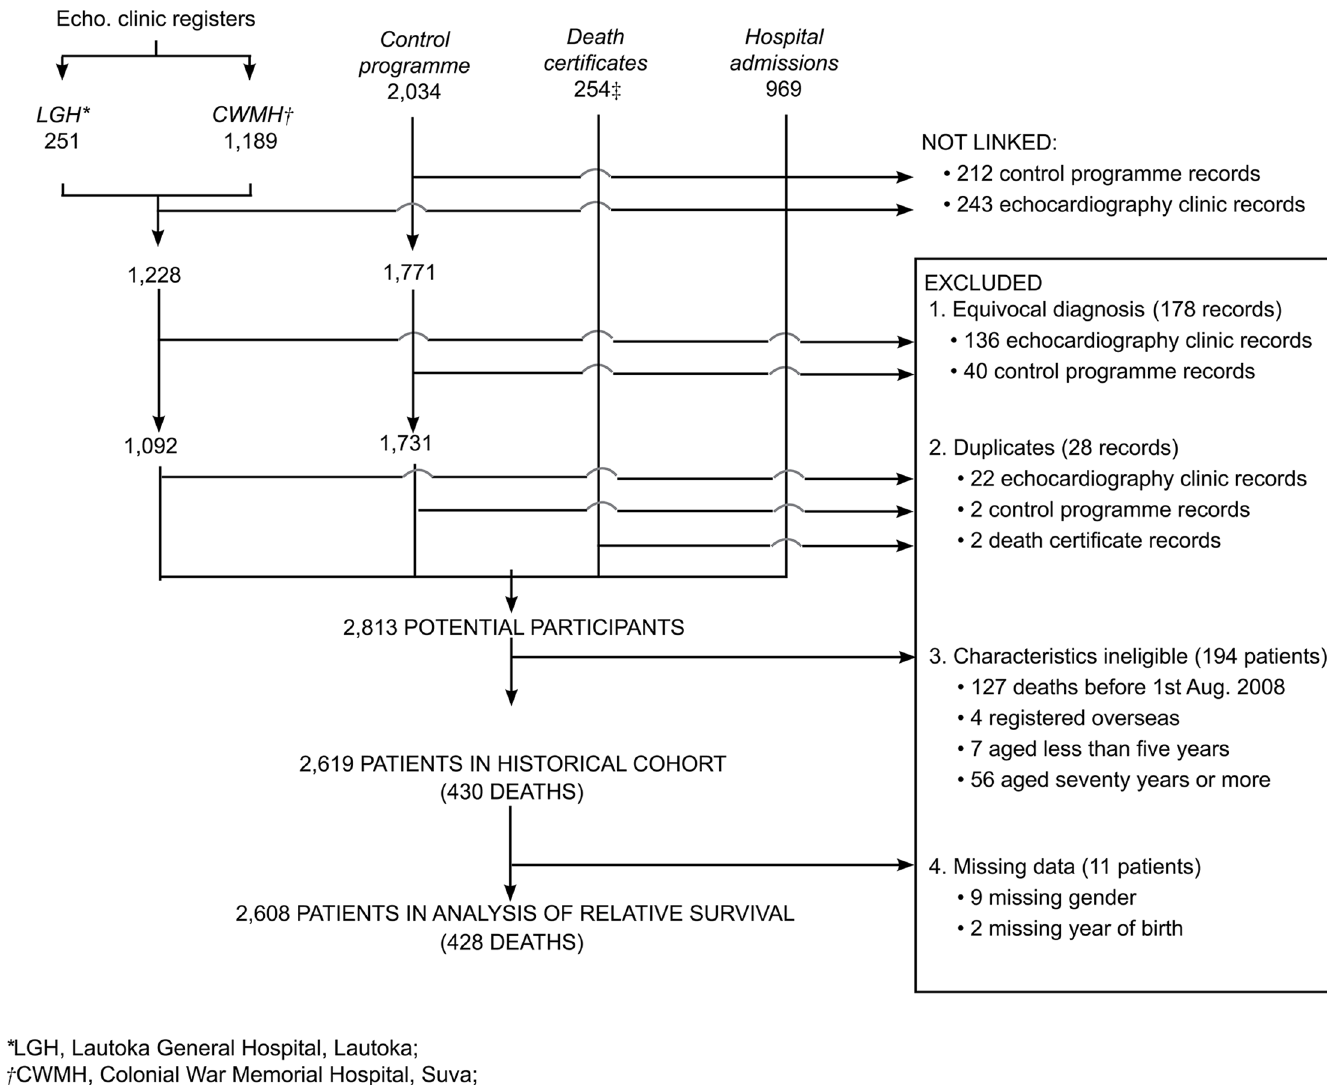
Fig 2. Flow diagram of